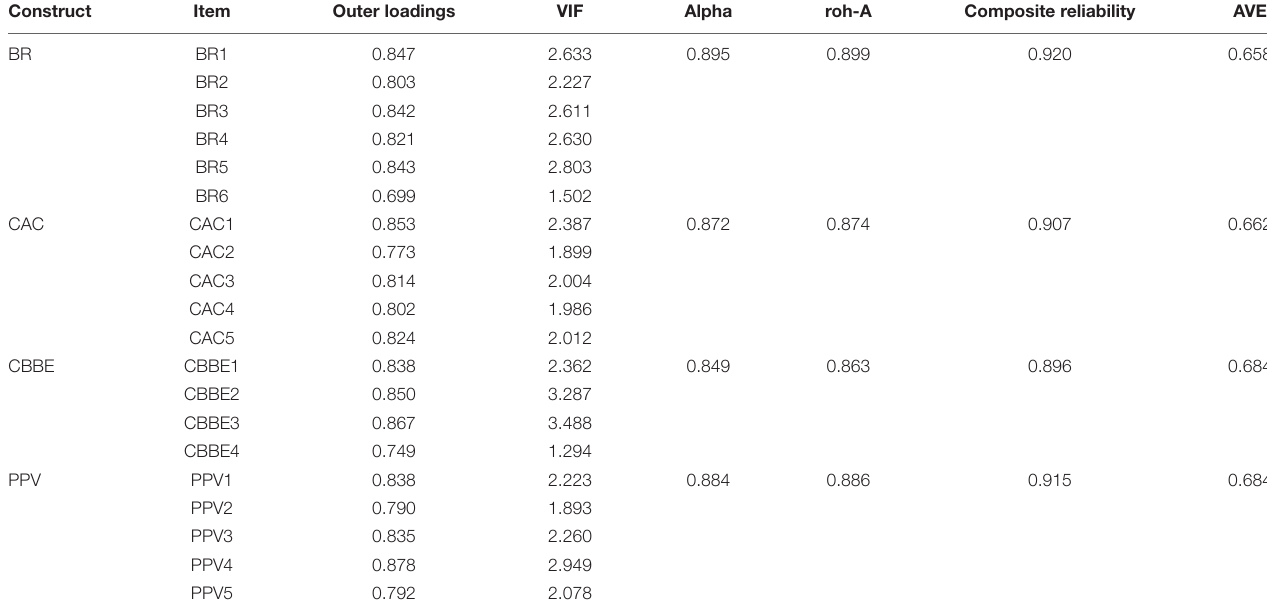
TABLE 1 | Reliability and convergent validity of the study constructs. Construct Item